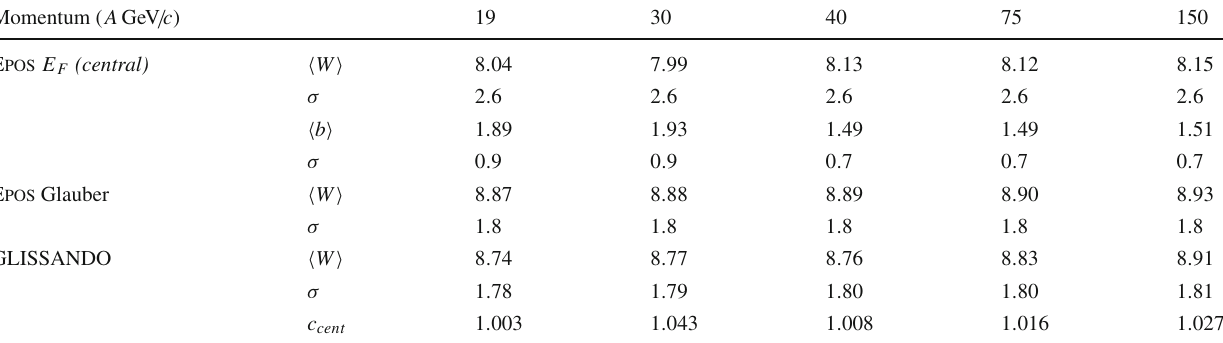
Fig. 3 PSD modules included in the calculation of the projectile spectator energy E PSD used for event selection for beam momenta of 19 A , and 30 A GeV / c (left) and for 40 A , 75 A and 150 A GeV / c (right) Table 2 Average number of wounded nucleons (cid:4) W (cid:5) and average col- using the smallest number of spectators in the Glauber model. Epos E F lision impact parameter (cid:4) b (cid:5) in the 20% most central Be+Be collisions results correspond to selecting events by the forward energy E F within estimated from simulations using the Epos [16] and GLISSANDO [21] the acceptance map in Ref. [18]. Also shown are correction factors c cent models. The values of σ denote the widths of the distributions of W needed to account for the different event selection procedures used for and b . Results Epos WNM and Glissando are for centrality selection the data (measured E PSD ) and the simulation (simulated values of E F